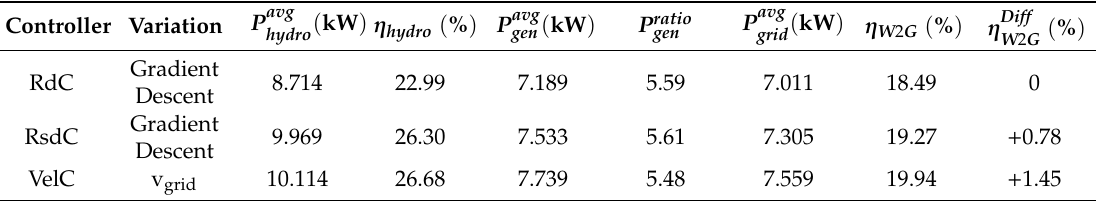
Figure 18. Results from a 1500 s simulation for a high-energy sea state. ( a ) Wave resource input generated from JONSWAP spectrum with significant wave height 1.95 m and energy period 7 s; ( b ) Instantaneous generator power and averaged grid power for the RdC Gradient Descent case; ( c ) Instantaneous generator power and averaged grid power for the RsdC Gradient Descent case; ( d ) Instantaneous generator power and averaged grid power for the VelC v grid case. Table 10. Summarized results from the 1500 s high-energy low occurrence wave simulation for RdC, RsdC and